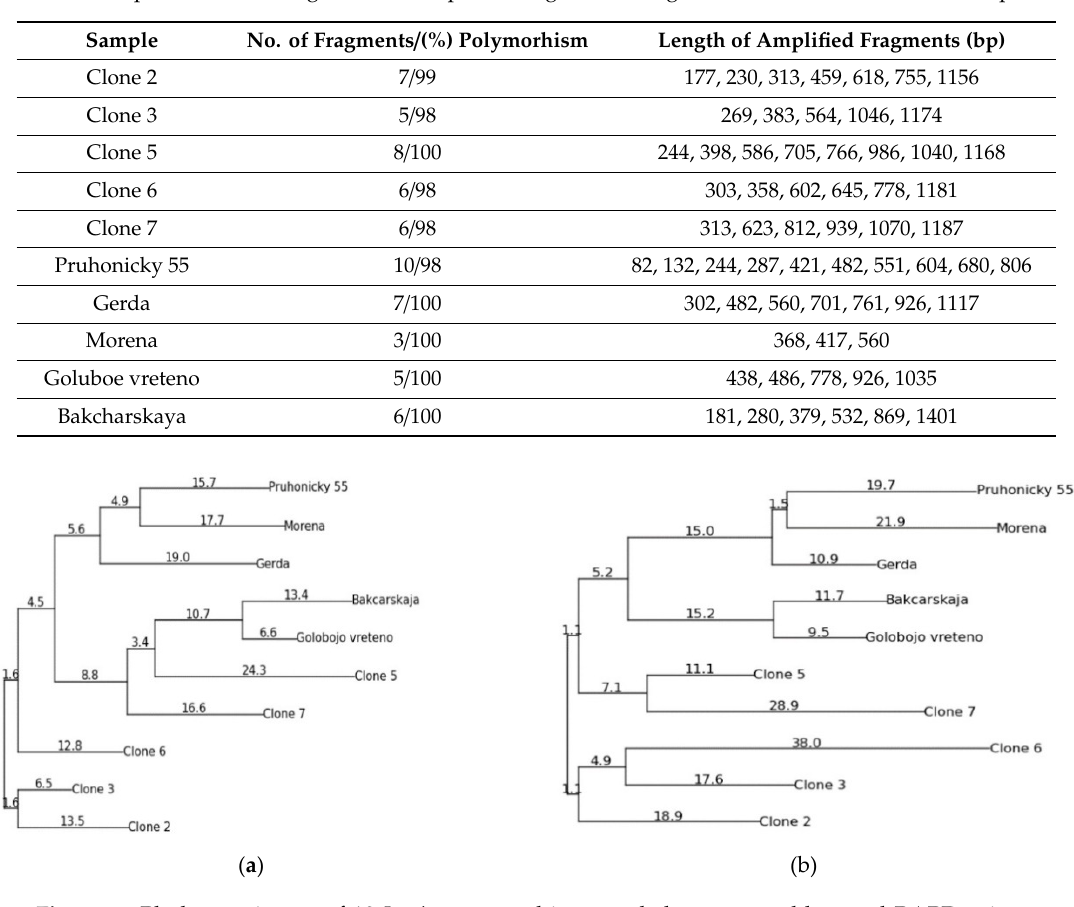
Figure 7. Phylogenetic tree of 10 Lonicera sp. cultivars and clones created by used RAPD primer 5 ′ ACCGCGAAGG3 ′ ( a ) and 5 ′ GGACCCAACC3 ′ ( b ).